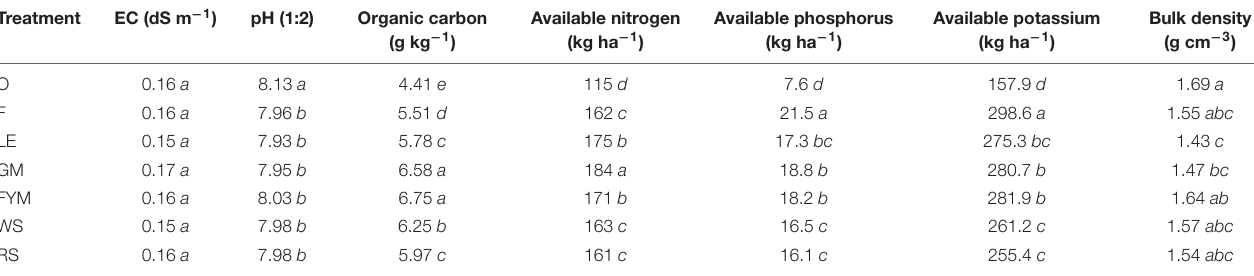
TABLE 1 | Physical and chemical properties of the soils under different treatments after 10 years of management (2015). Treatment